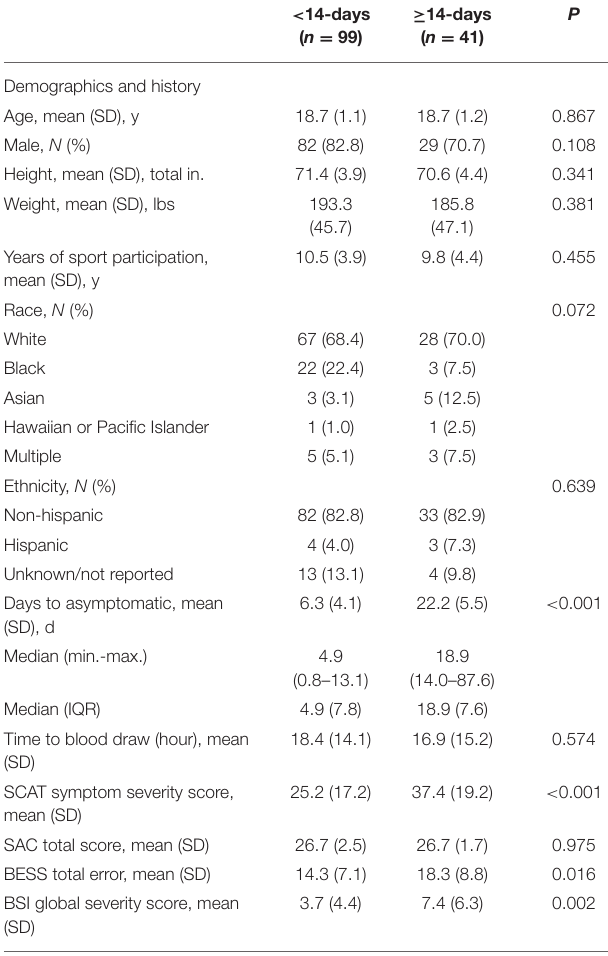
TABLE 1 | Sample characteristics of RTS